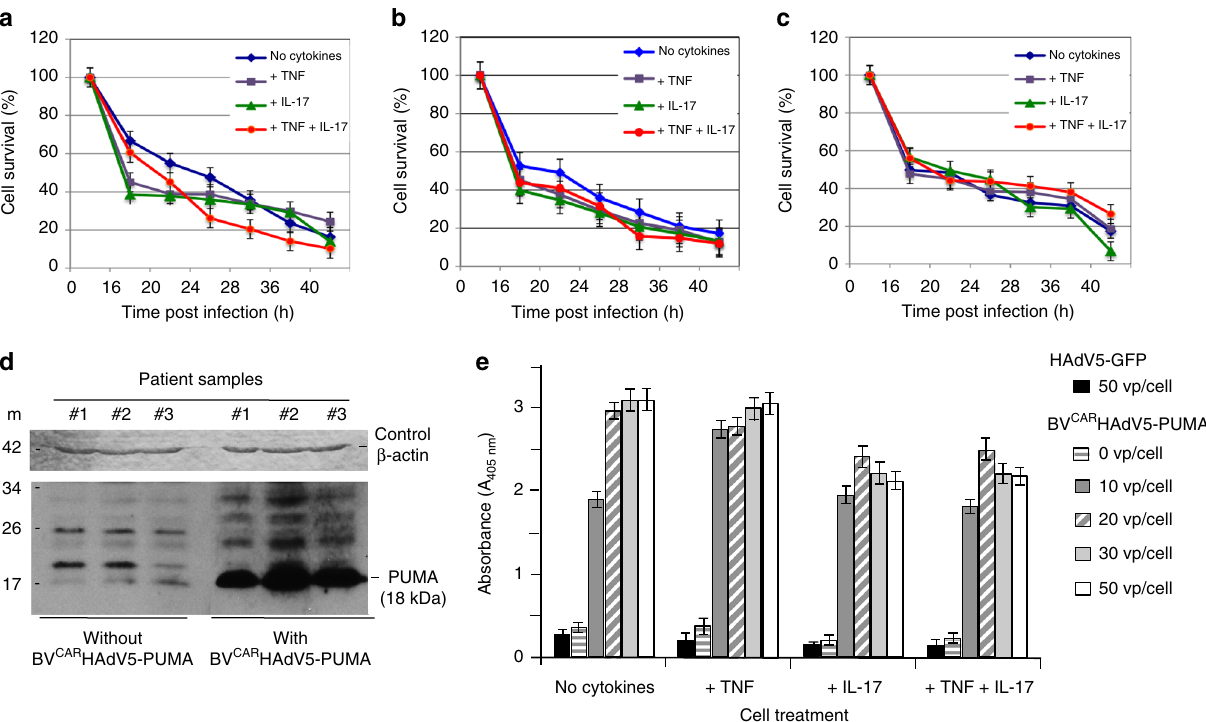
Fig. 3 BV CAR HAdV5-PUMA-induced apoptosis of FLS derived from clinical samples. FLS derived from synovium explants from three patients with RA a – c , nontreated or treated with cytokines TNF α and IL-17, were infected with BV CAR HAdV5-PUMA at a constant adenoviral vector dose of 50 vp/cell. The cell survival was monitored over 40 h, using the MTT assay. The number of surviving cells was expressed as the percentage of control cells taken at time 0 of infection, which was attributed the 100 per cent value. The average from three independent experiments, each performed in triplicates is presented. The error bars indicate standard error of the mean. Statistical analysis using one-way ANOVA test, *** P < 0.001, ** P < 0.01, * P < 0.05. d The expression of PUMA protein was analysed in FLS transduced or not with BV CAR HAdV5-PUMA at 50 vp/cell. Cells were harvested at 40 h post transduction, lysed and whole-cell lysates probed for PUMA protein using SDS – polyacrylamide gel electrophoresis and western blot analysis. ( bottom ) Luminogram of blot reacted with anti-PUMA RabMAb, peroxidase-conjugated anti-rabbit IgG antibody and enhanced chemiluminescence Detection Kit. ( Top ) Loading control (stained blot). Blot was reacted with anti- β -actin MoMAb, peroxidase-conjugated anti-mouse IgG antibody, and staining reaction performed with H 2 0 2 and 3,3 ’ -Diaminobenzidine. e To quantitatively measure cell apoptosis, FLS untreated or treated with individual cytokines TNF α and IL-17, or a mixture of TNF α and IL-17, were incubated with increasing doses of BV CAR HAdV5-PUMA, and harvested at 24 h post infection. DNA fragmentation and nucleosome release into the cytoplasm were determined using an immunological detection of histone-complexed DNA fragments. Lysates from mock-infected cells served as negative controls to evaluate the background level, i.e., the physiological nucleosome content of the cytoplasm. The results are expressed as the fold change over the background level, which was attributed the value of 1. The control consisted of FLS infected by BV CAR HAdV5-GFP at the highest dose of 50 vp/cell. Results presented are from three independent experiments, each in triplicates, using the one-way ANOVA test, *** P < 0.001, ** P < 0.01, * P <